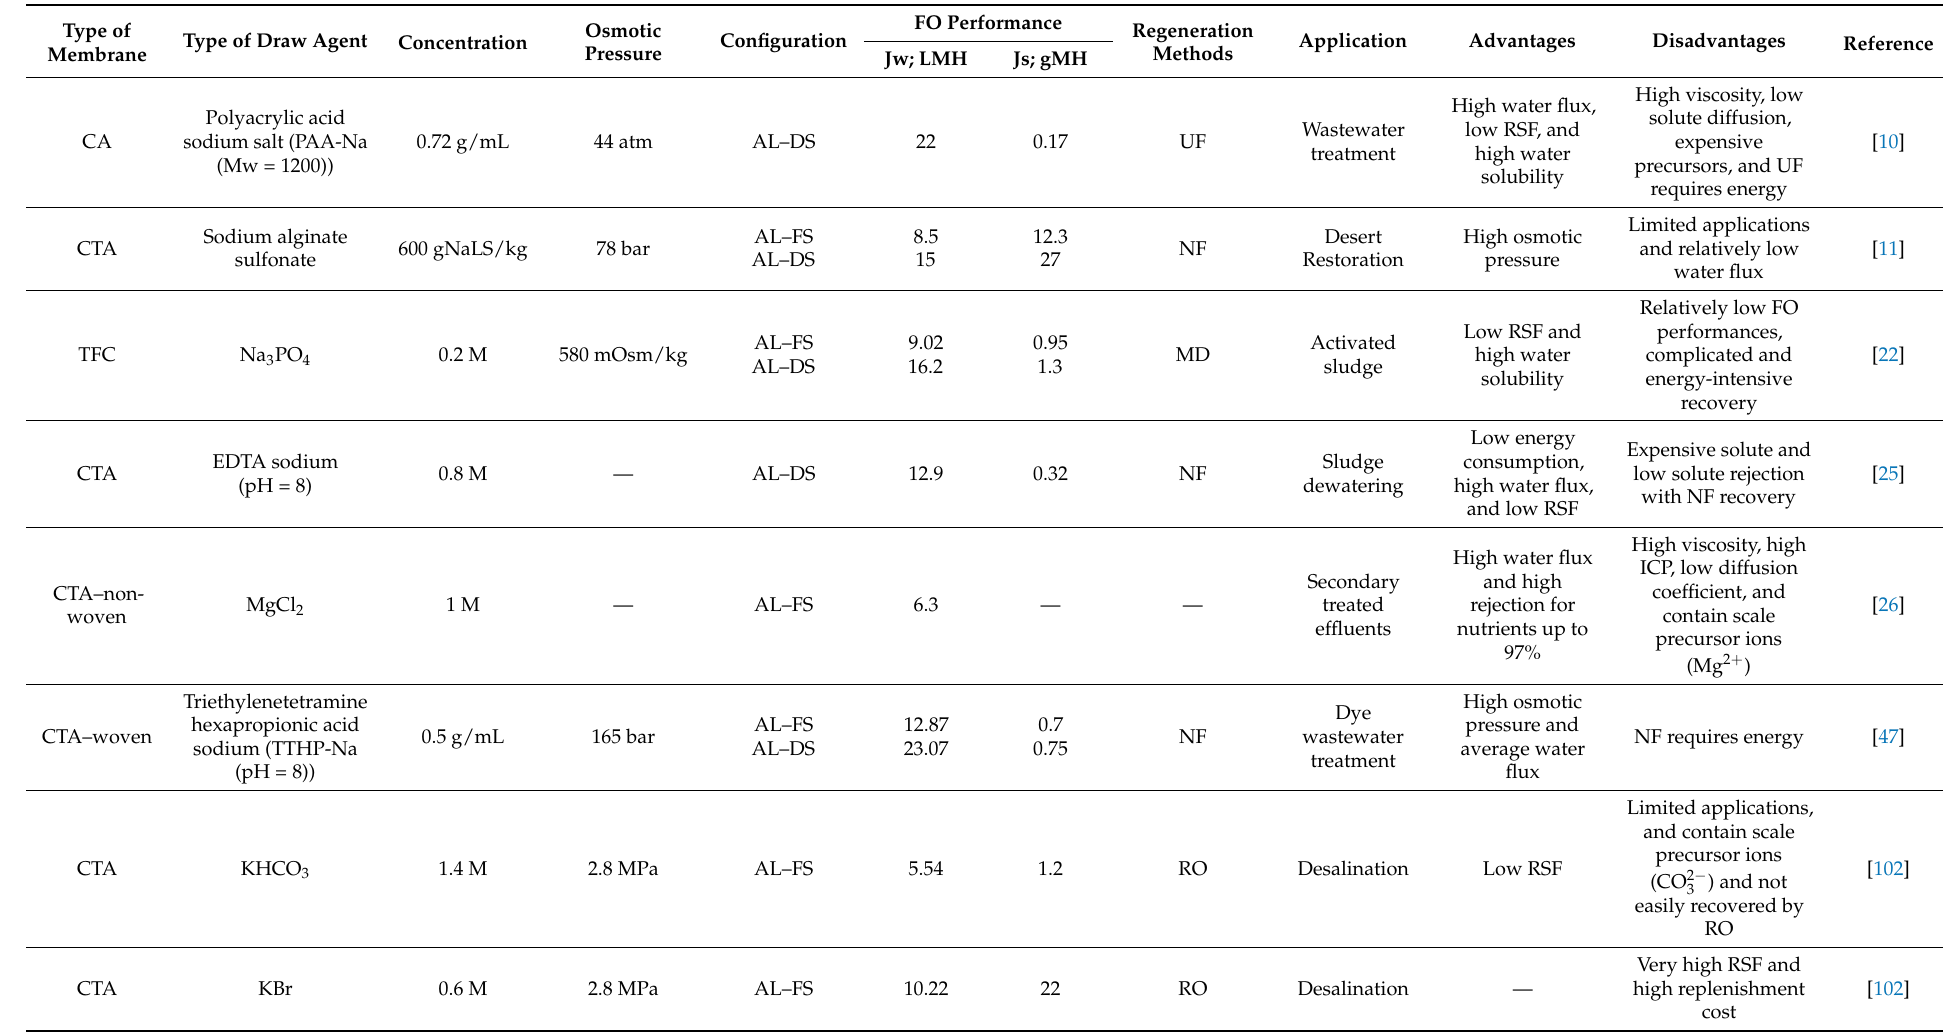
Table 2. Overview of the physicochemical characteristics of draw agents utilized in FO